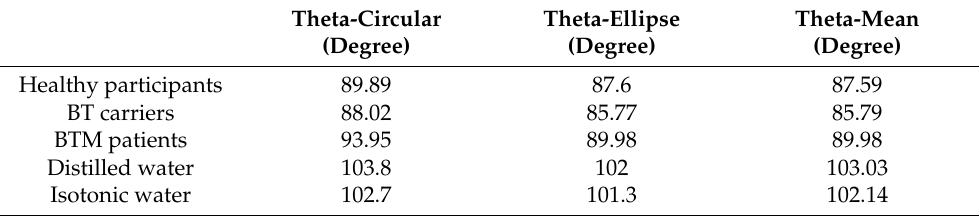
Table 4. Angular measurements, standard deviation, and uncertainty